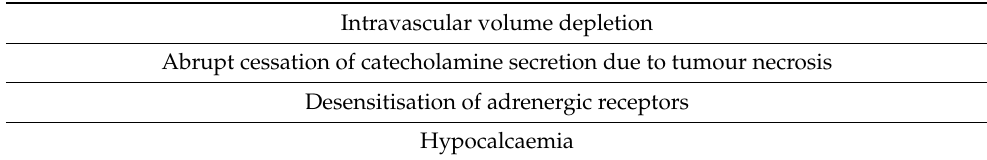
Table 6. Molecular events associated with shock after